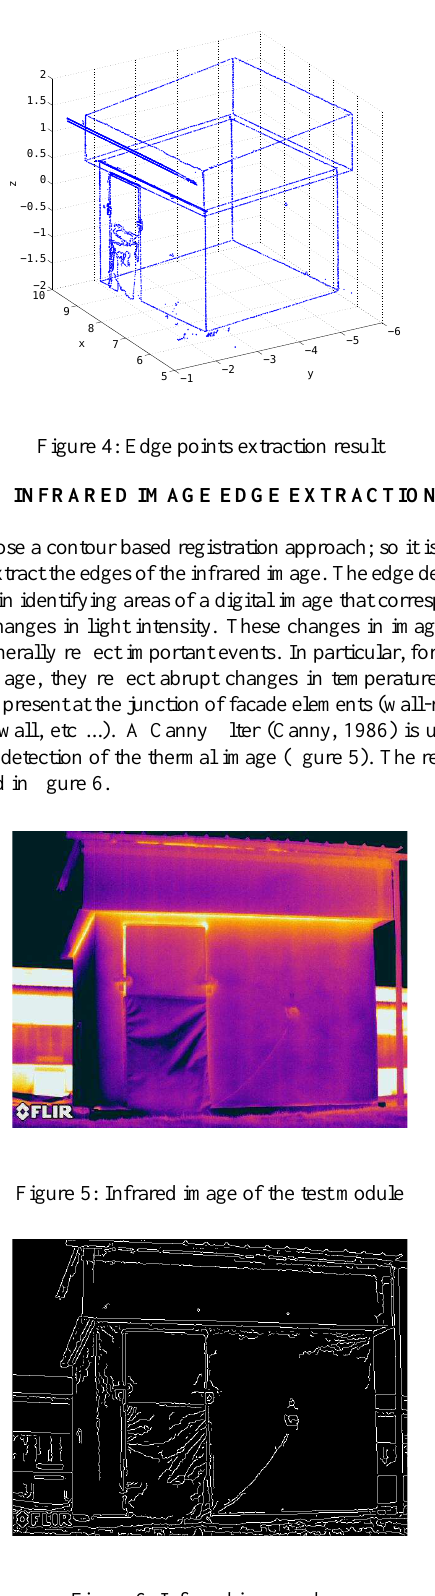
Figure 6: Infrared image edges 4 REGISTRATION